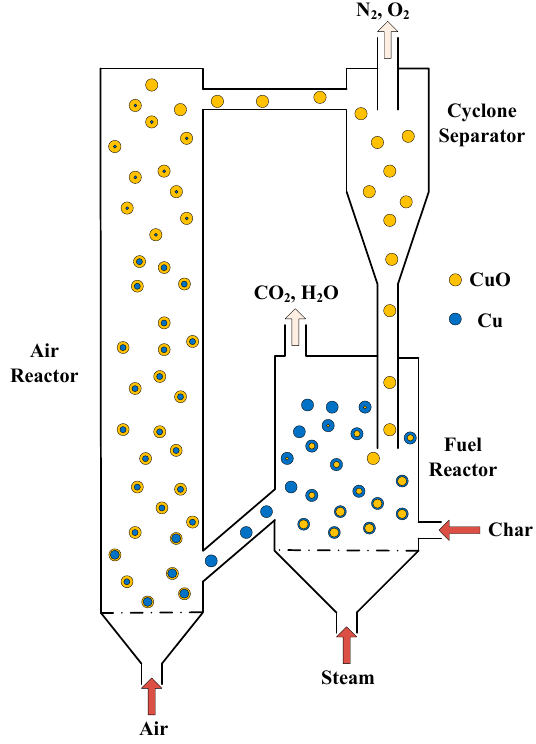
Figure 1. Schematic diagram of a conventional solid-fueled CLC system.